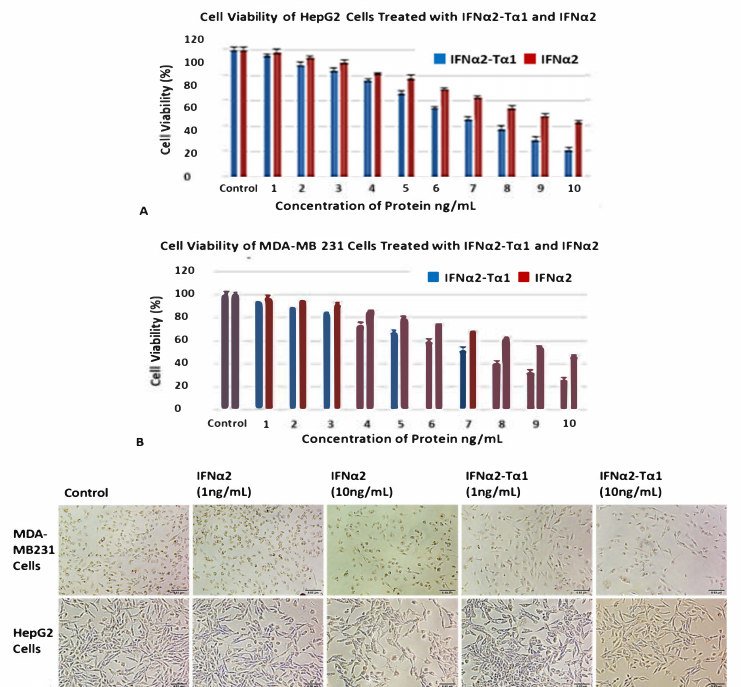
Figure 2. Inhibition of HepG2 and MDA-MB-231 cell proliferation by IFN α 2–T α 1 or reference IFN α -2. ( A ) HepG2 cells and ( B ) MDA-MB-231 cells treated with various concentrations of IFN α 2–T α 1 or IFN α 2 alone for 24 h and cell viability (%) determined by neutral red assay. Data are represented as Mean ± SD (n = 3, two-way ANOVA, p < 0.05 considered significant with 95% confidence). ( C ) IFN α 2– T α 1 and IFN α 2-treated MDA-MB-231 and HepG2 cells observed under 10 × magnification after staining with neutral red dye.